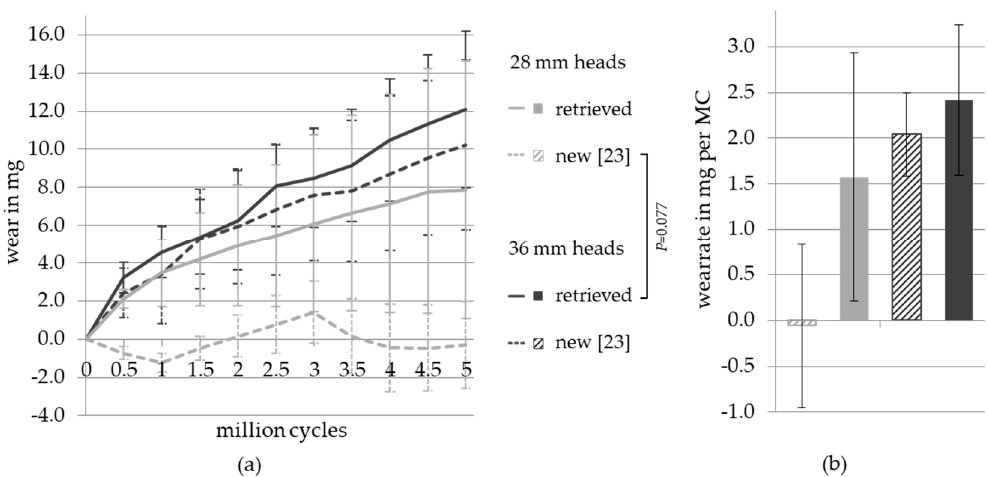
Figure 2. Mean gravimetric wear of the sequentially cross-linked polyethylene (PE) liners combined with new [23] and retrieved 28 and 36 mm alumina femoral heads. ( a ) Total wear over five million cycles and ( b ) wear rates per million cycles.